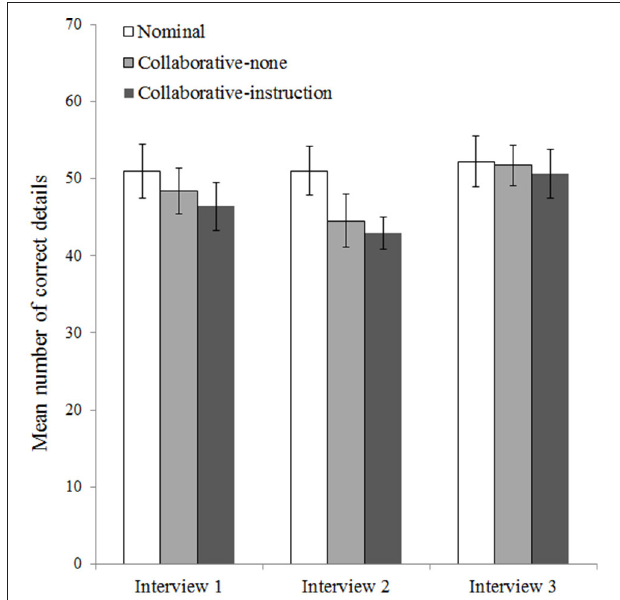
FIGURE 1 | Mean number of correct details mentioned by pairs in the nominal ( n = 25), collaborative-none ( n = 25), and collaborative-instruction ( n = 25) conditions during the first, second, and third interview. Error bars represent 95% confidence